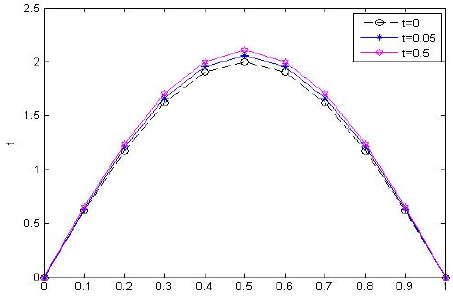
Figure 1. Numerical solution of Eq.(1) for various values of t .